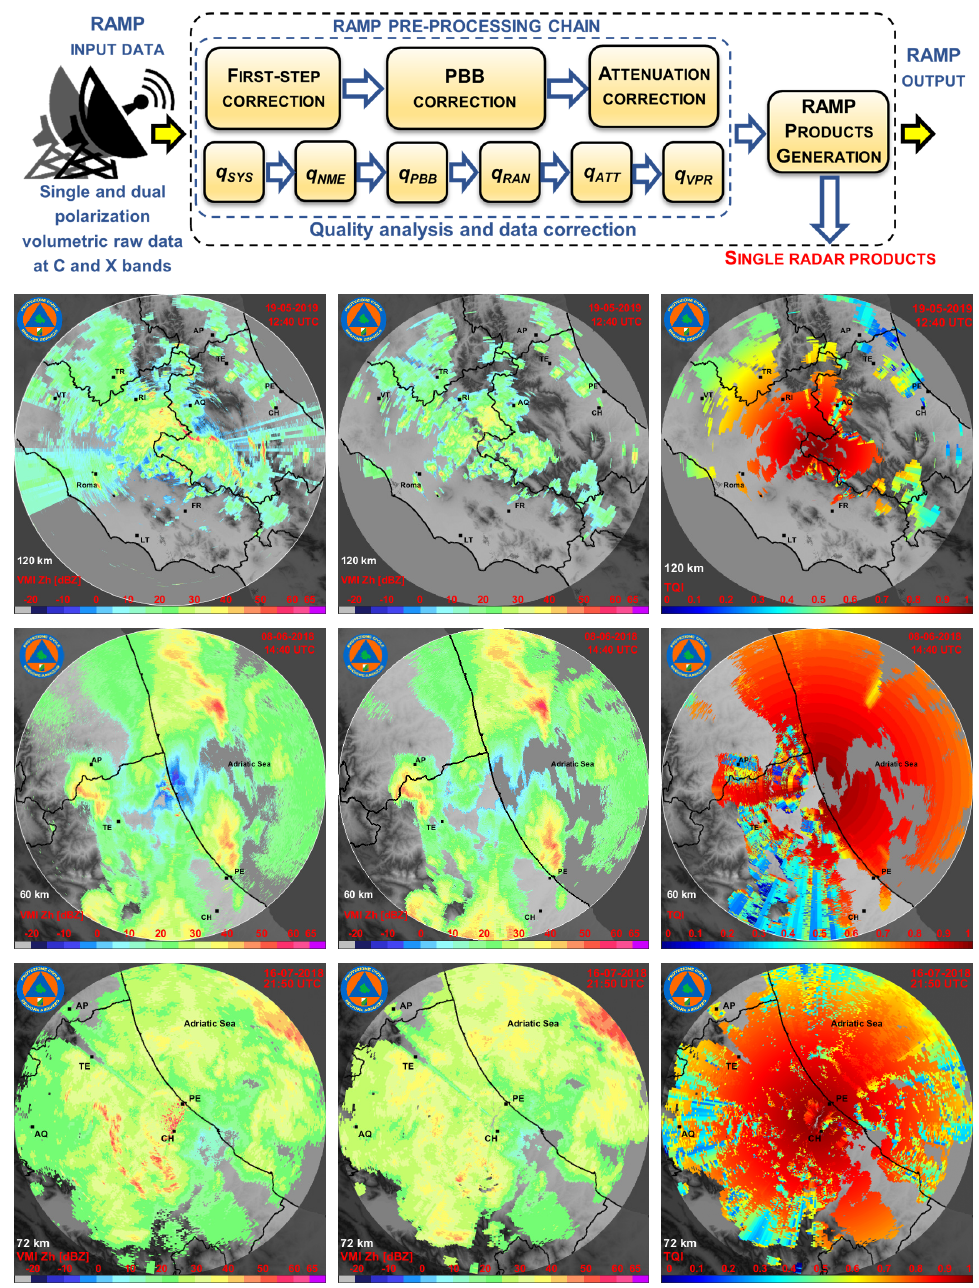
Figure 2. ( Top ) RAMP chain scheme and ( bottom ) an example of RAMP application to the Mt. Midia (MM), Tortoreto (TO) and Cepagatti (CE) radars: VMI product before ( left ) and after ( center ) data correction as well as the total quality index (TQI) is also shown ( right ). Table 2. List of the main products of each single radar using RAMP within the Abruzzo network composite. RAMP modules are briefly described in Appendix.